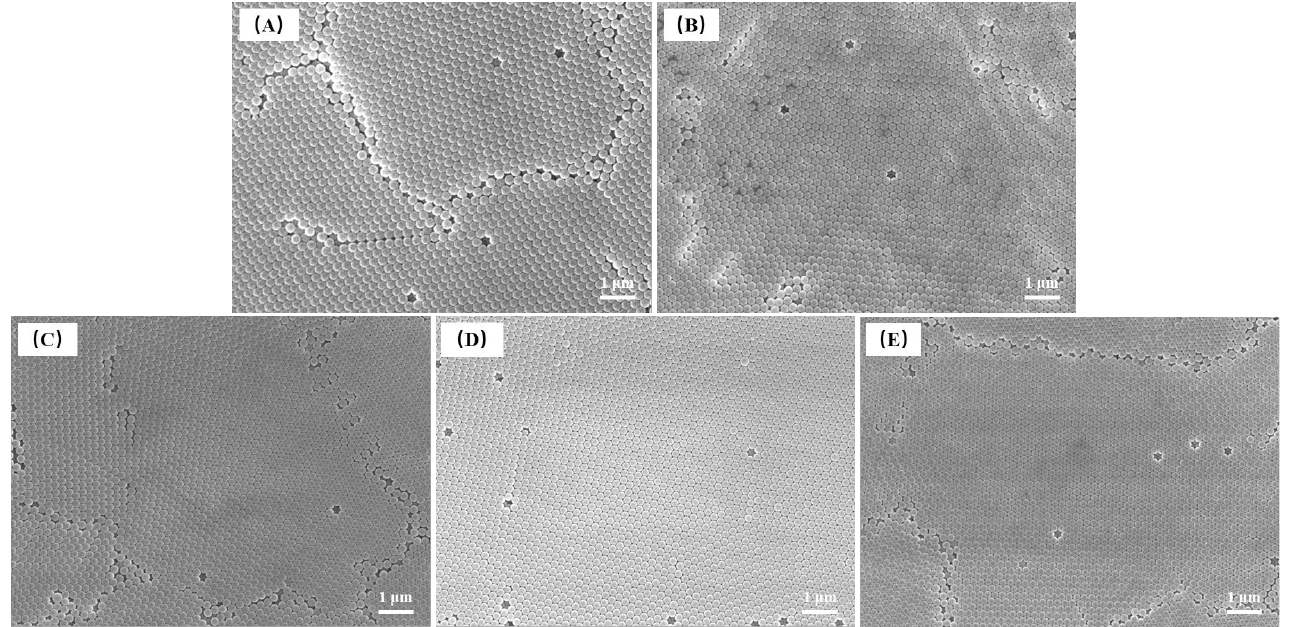
Figure 8. FE-SEM images of P(St-AA) colloidal microspheres synthesized with different amounts of